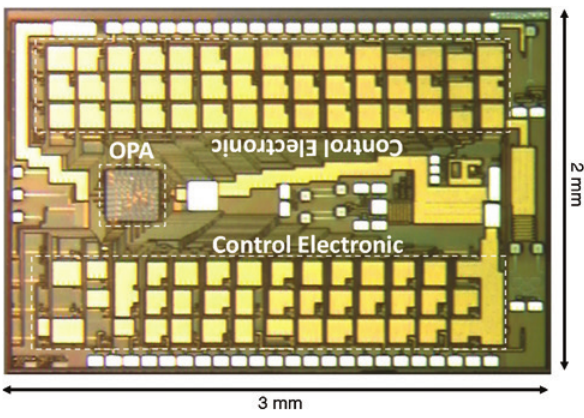
Figure 7: Microscope picture of an 8 × 8 OPA, monolithically integrated with control electronics in a 180-nm CMOS process. Reprinted by permission of The Optical Society [21].